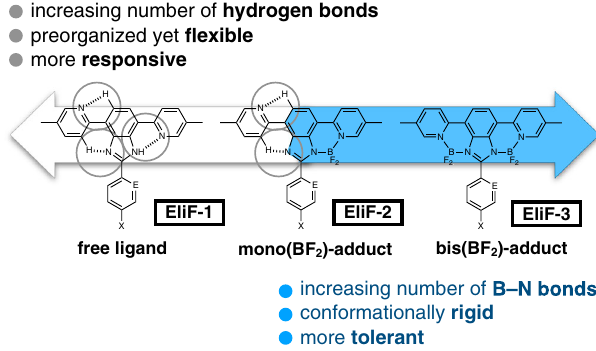
Fig. 1 | Design principles of EliF. Main-group coordination chemistry converts non-covalent N – H···N hydrogen-bonding contacts to rigid B – N coordinate bonds, whichprofoundlyimpactstheenvironment-sensitivityandemissionquantumyield of the fl uorogenic skeleton.